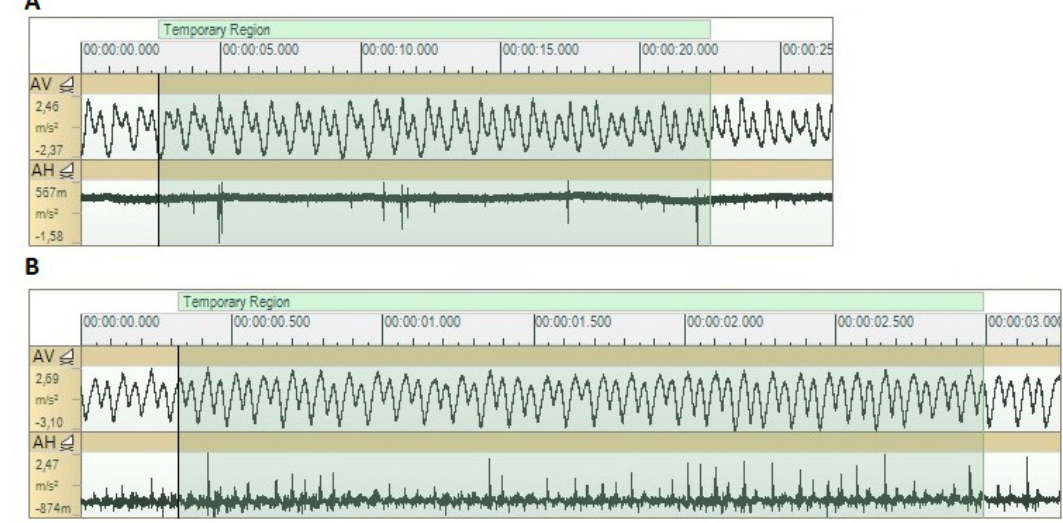
Figure 9. Signals measured on the UVABB tool along its vertical and transverse directions, during tests with vibrations ON. ( A ) 90 mm/min, 250 N, 1 pass. ( B ) 900 mm/min, 400 N, 3 passes.